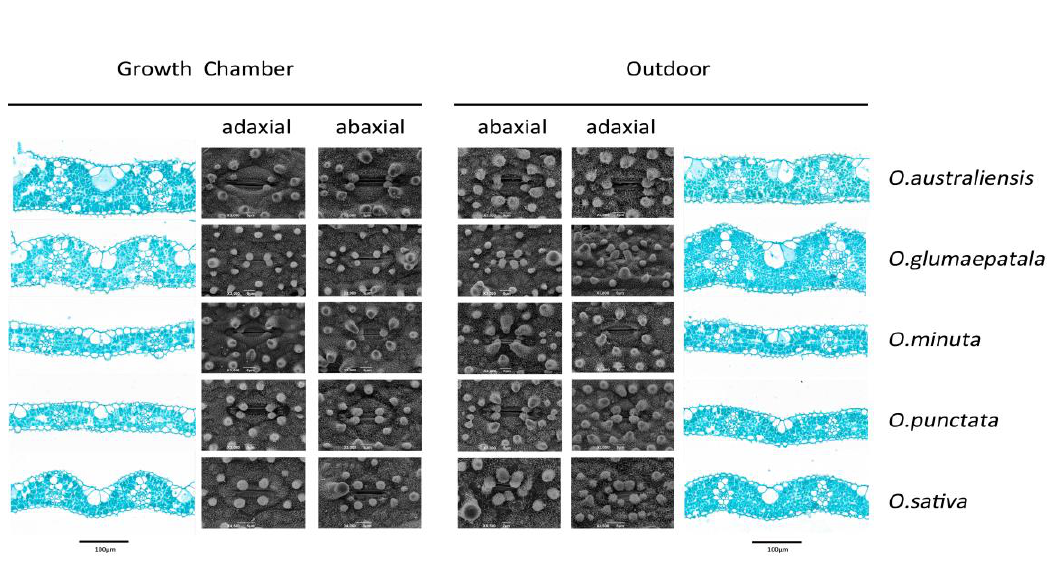
Figure 2. Plasticity of leaf anatomy and stomatal morphology in response to growth conditions for five Oryza species.